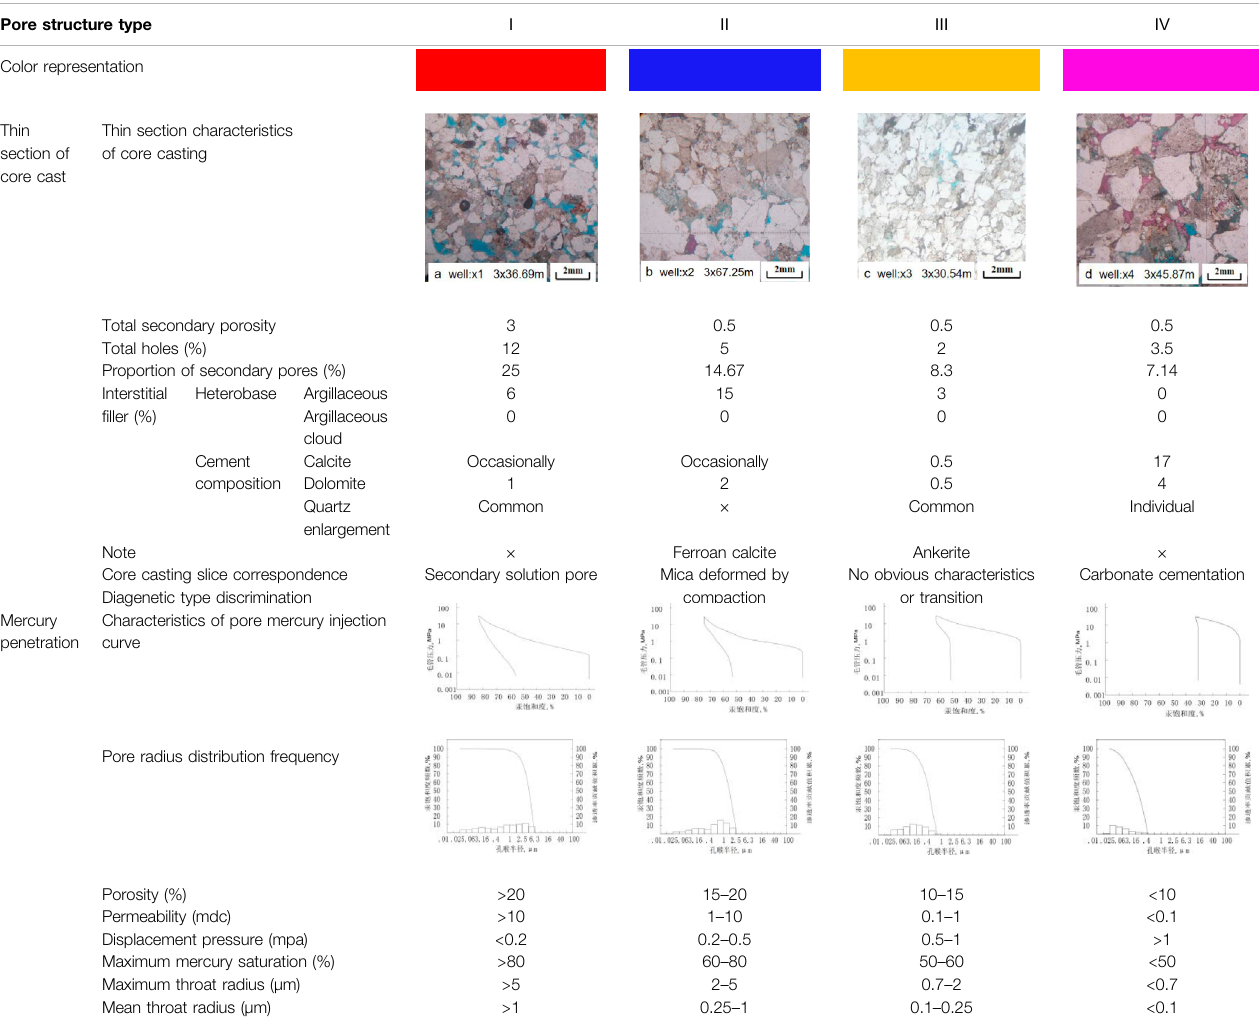
TABLE 3 | Classi fi cation standard of pore structure of the Es 3 reservoir. Pore structure type